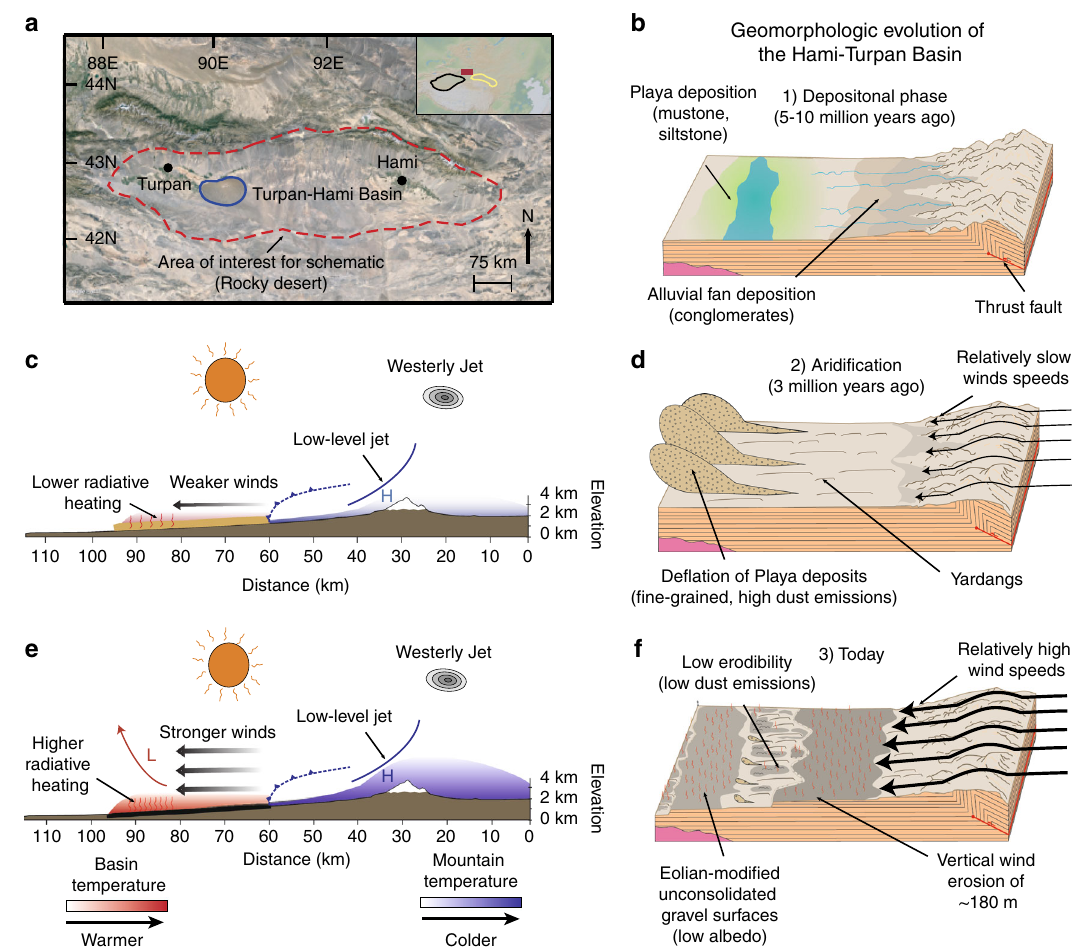
Fig. 1 Schematic illustration of the geomorphologic development of the Hami Basin. a Map of the Hami-Turpan depression, with major cities labeled. The red dotted line encircles the stony desert described by the schematic. Blue solid line indicates area of dune fi eld. Inset displays physical map of East Asia. Red square represents the region shown on the larger map. Black and yellow lines mark the approximate extent of the Tarim Basin and Hexi Corridor, respectively. b Depositional phase of Neogene sediments. Conglomerate facies were likely derived from alluvial fans, while fi ner-grained siltstones and mudstones originated from playa deposition. c , d Regional climate system and landscape present during initial aridi fi cation of the Hami Basin, likely in the late Miocene or Pliocene. d The lighter-colored fi ner-grained playa deposits are easily wind-de fl ated, meaning more dust emissions. c However, northerly winds moving across the depression were likely weaker than present, due to a smaller mountain-basin temperature gradient from higher albedo of the low- lying basin. e , f Present-day version of the Hami landscape and climate. f Vast areas of dark-colored, coarse-grained topographically tiered, eolian-modi fi ed gravel surfaces, exposed by wind de fl ation of fi ner particles, maintain low albedo. e The lower albedo increases surface temperature of the depression relative to ( c , d ) and creates a higher temperature gradient, leading to higher surface wind speeds. Modi fi ed from ref. 30 . Figure 1a made with